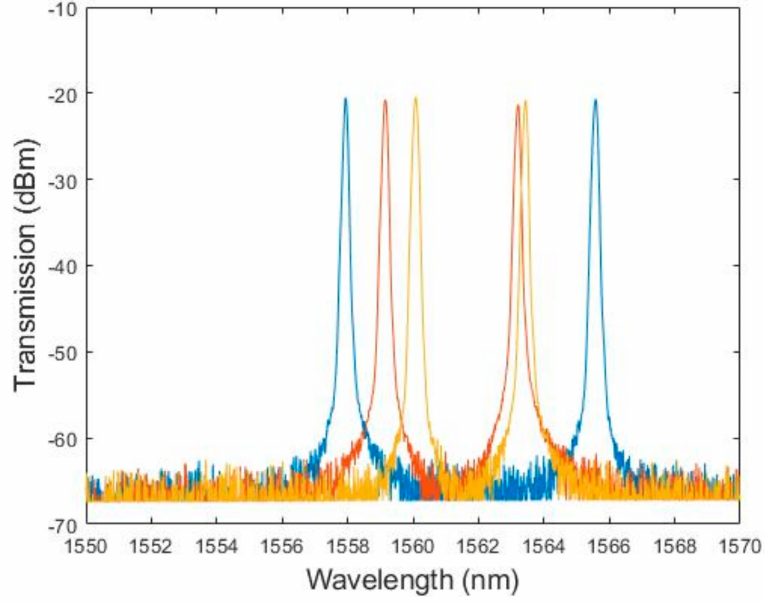
Figure 3. Dual-wavelength output